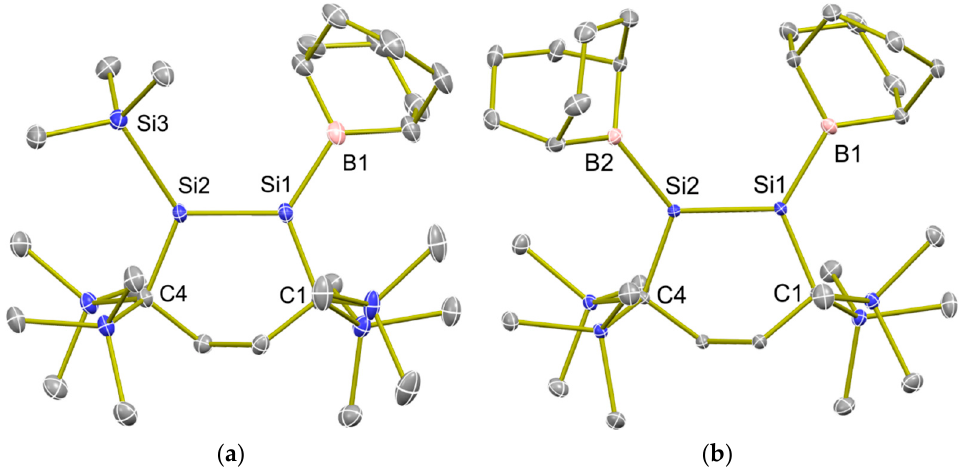
Figure 2. Molecular structures determined by single-crystal XRD analysis (atomic displacement parameters set at 50% probability; hydrogen atoms omitted for clarity). ( a ) Compound 3 and ( b ) compound 4 . Table 1. Selected structural parameters of 3 , 4 , and related compounds.